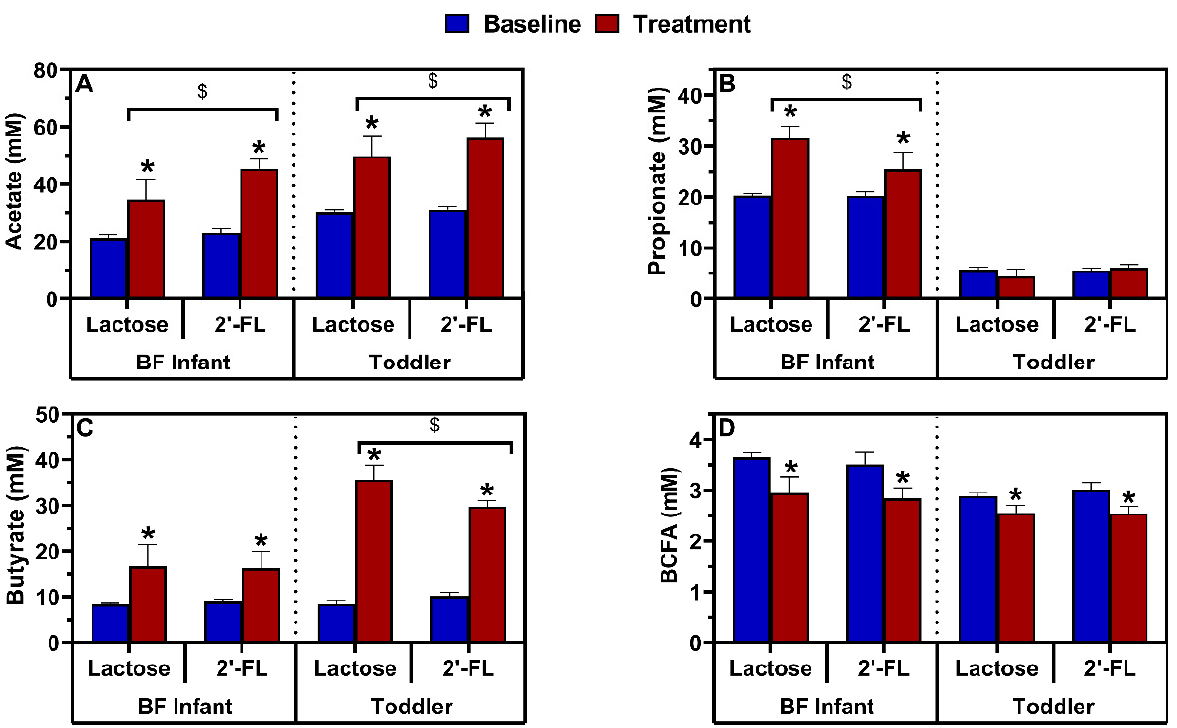
Figure 7. Effect of lactose or 2’-FL on microbial activity in the proximal colon in long-term-term colonic incubations. Bars represent the average ( ± SD) ( A ) acetate, ( B ) propionate, ( C ) butyrate and ( D ) BCFA levels (mM) at baseline (d0–d14; n = 6) and after treatment (d14–d35; n = 9) in the simulated proximal colon of the BF infant and toddler M-SHIME ® . 2’-FL = 2’fucosyllactose; BF = breastfed; d = day; BCFA, branched-chain fatty acids; M-SHIME ® = mucosal simulator of the human intestinal microbial ecosystem; SD, standard deviation. For each age group, significant treatment effects (baseline versus treatment) are indicated with an asterisk (*; p <0.05), whereas significant treatment effect differences (lactose versus 2’-FL) are indicated with a dollar symbol ($; p <0.05), as tested with a two-way ANOVA with Bonferroni correction.